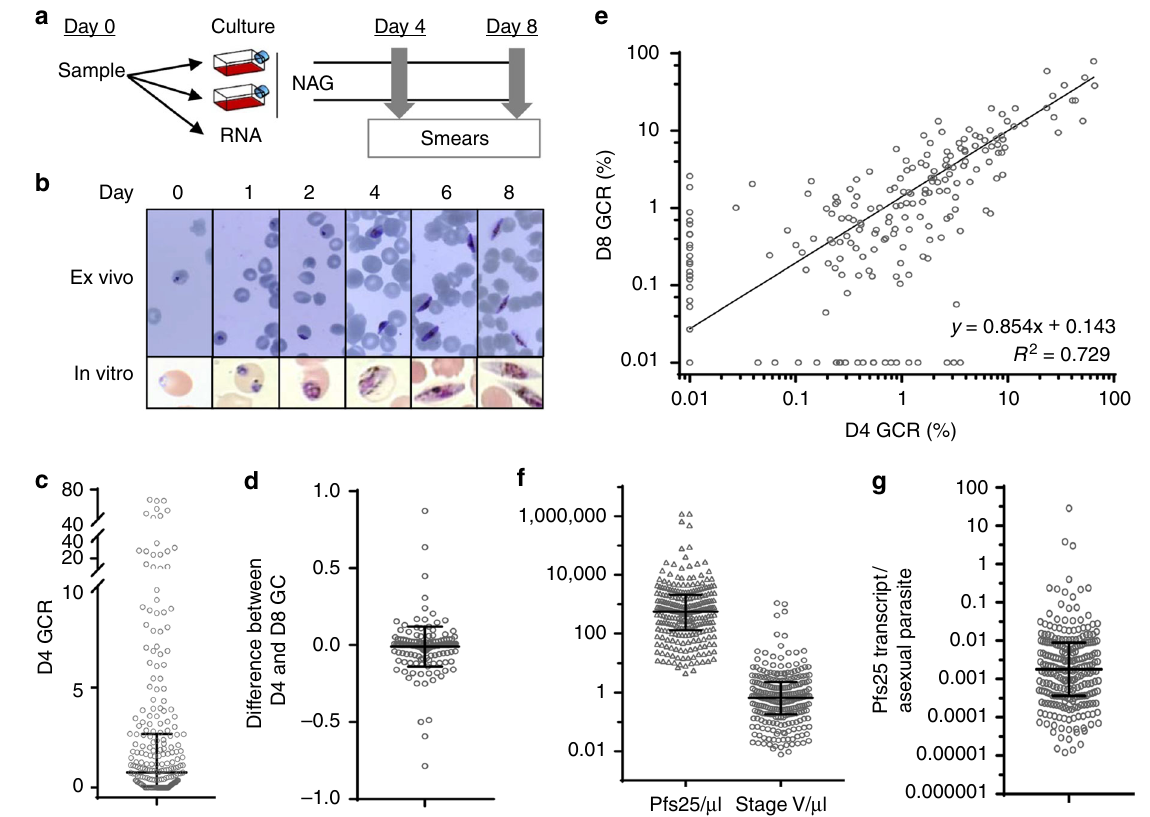
Fig. 1 Gametocyte-committed ring quanti fi cation in patient samples. a Schematic of the GCA experimental set up. Each blood sample from an uncomplicated malaria patient was divided into 3 aliquots, 1 for a blood smear and clinical analysis, 1 for RNA isolation and the rest used for ex vivo culture in the presence of NAG. Culture smears were made daily to monitor parasite development. Parasitemia was quanti fi ed on Days 0, 4 and 8 and the GCR was calculated by dividing the stage II/III gametocytemia of D4 or the stage III/IV/V gametocytemia on D8 by the D0 ring stage parasitemia. b Giemsa- stained smears of a representative ex vivo sample and in vitro culture of the lab-adapted strain NF54. c The D4 GCR for each sample and the median and interquartile range is shown. d The difference between the D4 and D8 gametocytemias (GC) is plotted for each sample and the median and interquartile range is indicated. e Each subject ’ s D4 and D8 GCR data is plotted on the X and Y axis, respectively, and the trend line and correlation coef fi cient ( R 2 ) are indicated ( n = 237). f Pfs25 RNA levels were determined for each D0 blood sample using RT-qPCR and the number of Pfs25 transcripts and stage